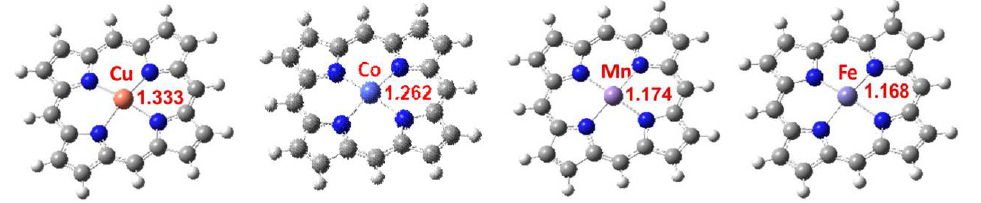
Figure 7. The optimized molecular structures of the metalloporphyrins with different metal